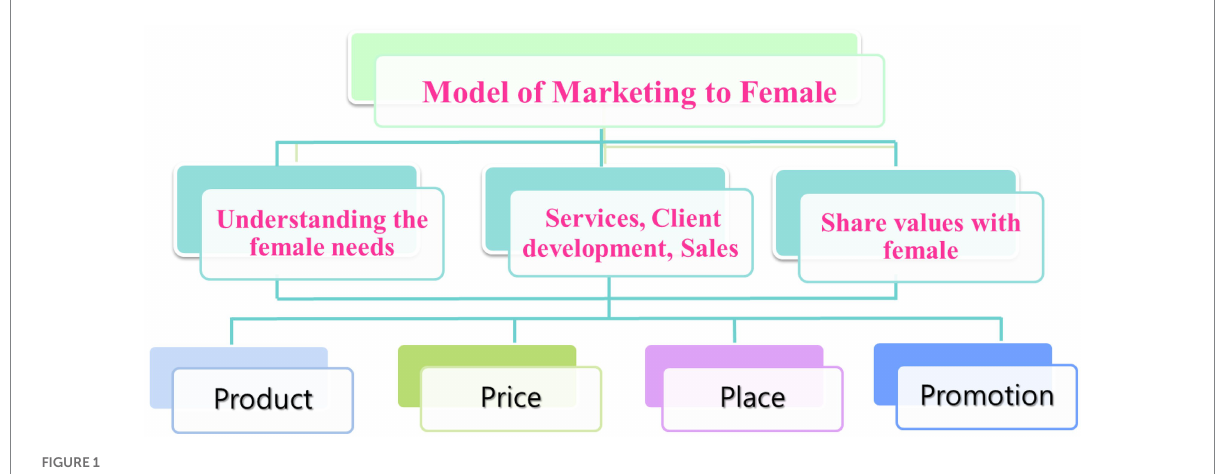
FIGURE 1 Female’s innovation marketing